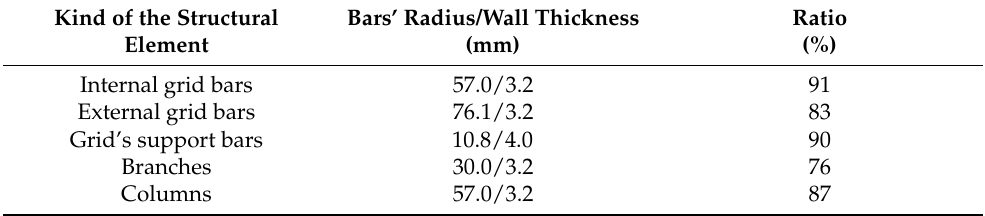
Table A1. Structural analysis results of structure 1a performed by Robot Structural Analysis Profes- sional software.